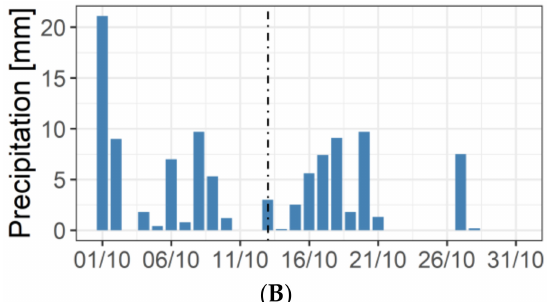
Figure 3. ( A ) Daily precipitation over the Belgian loam belt study area for August 2018 and the beginning of September 2018. The vertical dashed lines represent the acquisition dates of the Sentinel-2 (24 August) and Airborne Prism Experiment (APEX) images (2 September). Precipitation from weather stations was interpolated on 25 × 25 km grid. Source: Agri4Cast. ( B ) Daily precipitation recorded at the Sombre ff e weather station in October 2019. The vertical dashed line represents the acquisition date of Sentinel-2 image on 13 October 2019. Source: CRA-W / R é seau